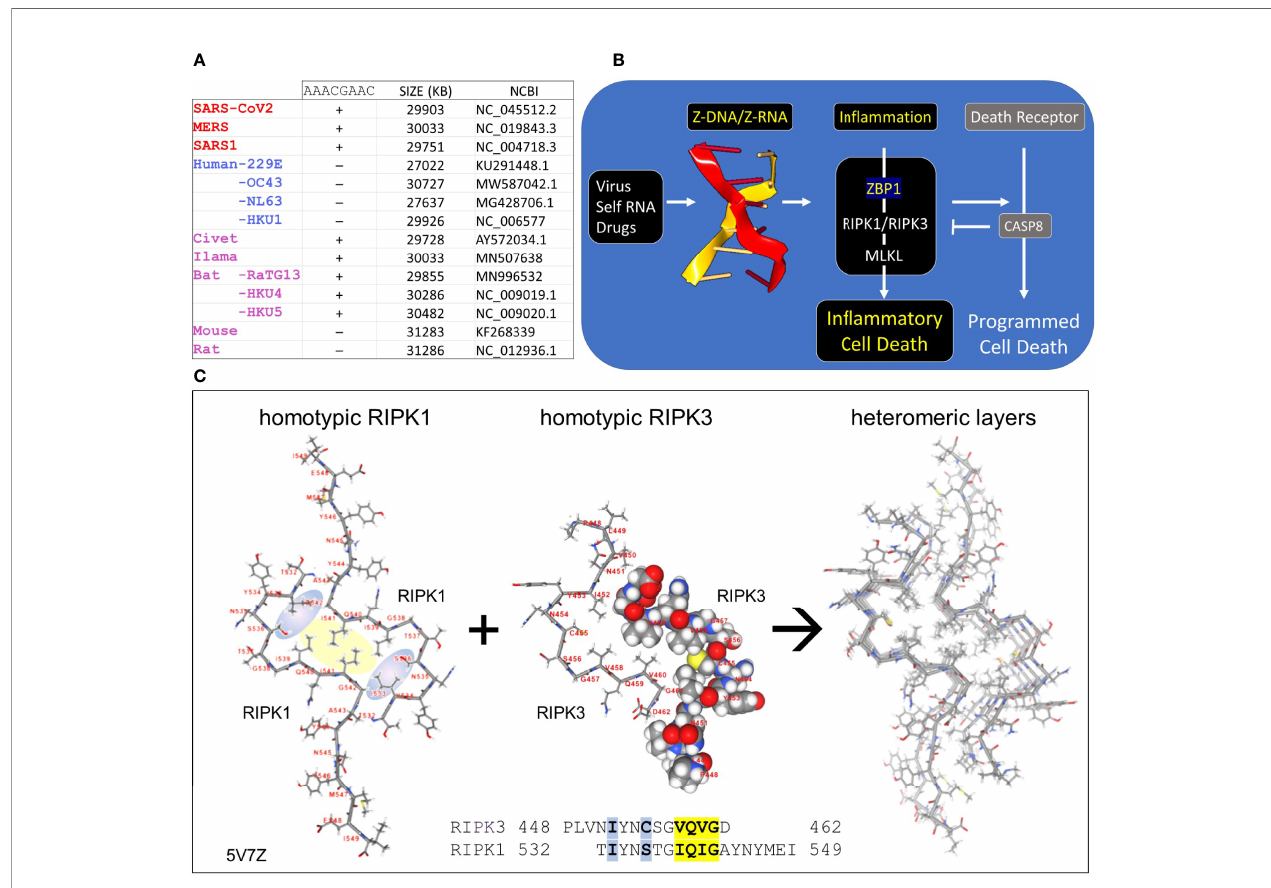
FIGURE 1 | Coronaviruses and human host susceptibility (A) Coronaviruses (CoV) with the AACGAAC transcription regulatory sequence (TRS) and red labels are associated with severe disease in humans. This TRS is present in CoV from other species but not in all human CoV, especially those that cause mild disease (B) Host responses to double-stranded Z-RNA viruses can produce in fl ammatory cell death through the activation of Receptor Interacting Protein Kinases (RIPK) by Z-DNA binding Protein q (ZBP1). The interaction between RIPK and ZBP1 is through their RIP Homotypic Interaction Motifs (RHIM). (C) Dimers formed from each RHIM protein stack on each other to form a fi ber that provides a scaffold for the host response machinery to assemble. The interaction of RIPK1 and RIPK3 is shown with the sequences contributing to the hydrophobic core highlighted in yellow. Blue highlights other residues that stabilize the core. The central fi gure shows a space- fi ll representation of one RIPK3 chain present in the